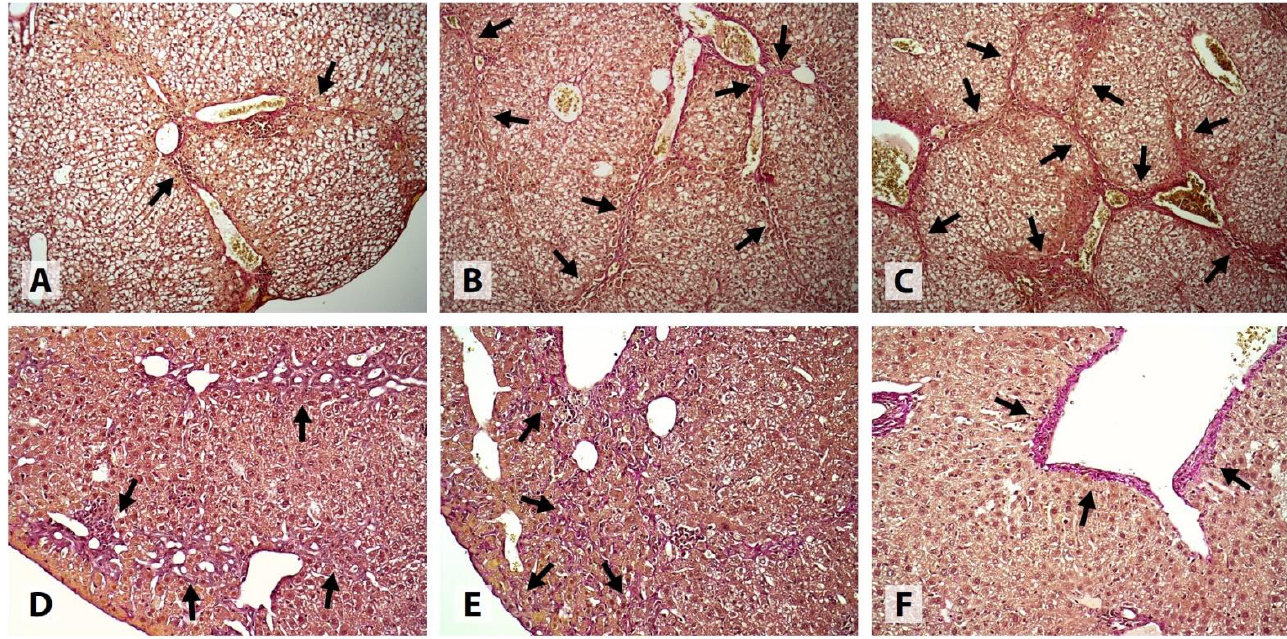
Figure 4. Signs of liver fibrosis in the experimental groups. ( A – C ) Control: moderate-to-severe intralobular perisinusoidal and central vein fibrosis, numerous fibrotic septa (arrows); van Gieson stain, ×100. ( D ) LOLA: mild focal perisinusoidal fibrosis (arrows); van Gieson stain, ×200. ( E , F ) EMPA: mild focal perisinusoidal fibrosis ( E ), moderate focal central vein fibrosis ( F ) (arrows); van Gieson stain, ×200.